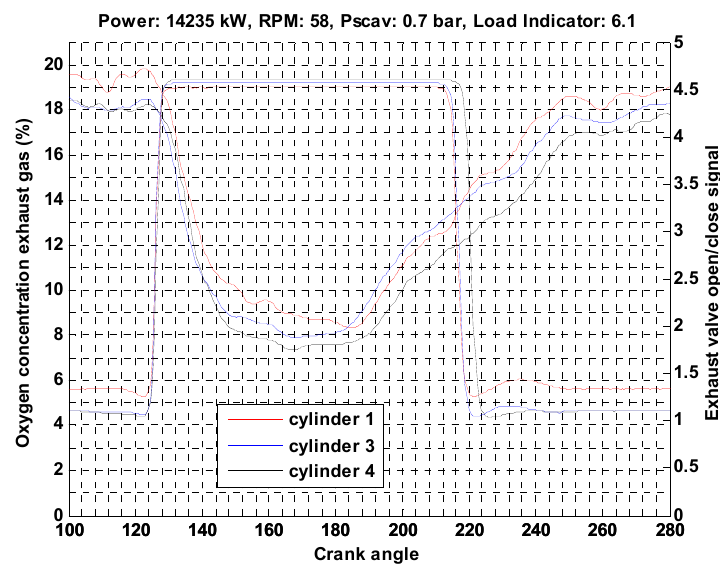
Figure 11. Oxygen concentration signature with respect to exhaust valve timing vs. crank angle degrees (aTDC).